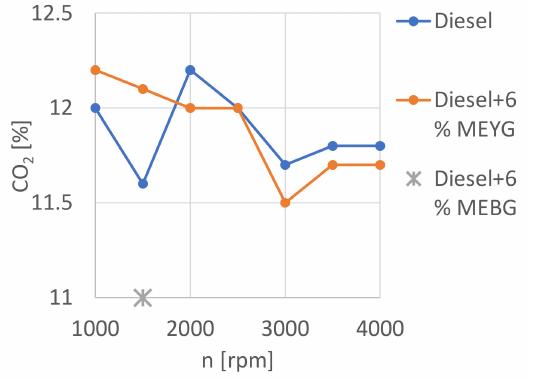
Figure 10. The CO 2 emissions at full engine load.